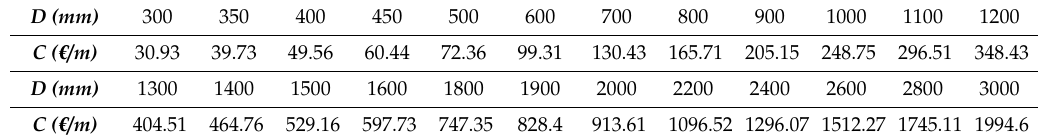
Table 3. Full range ( ND = ND max ) of commercial diameters used in the